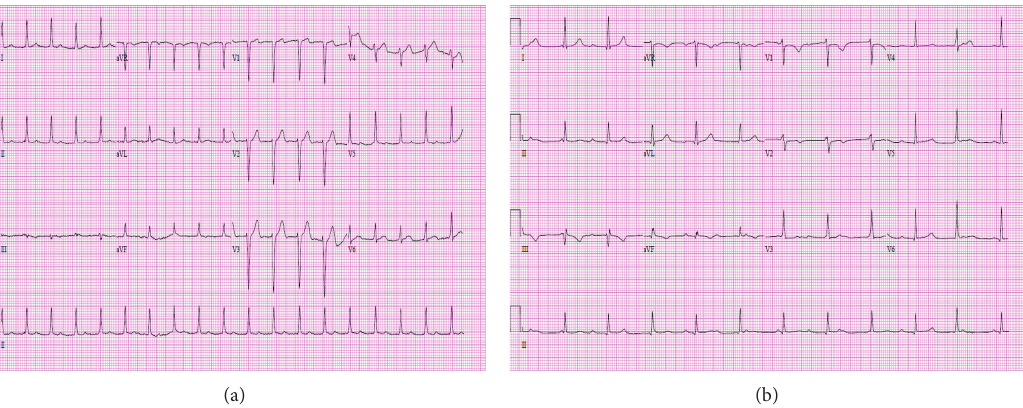
Figure 2: Electrocardiogram. Day 1 ECG on left and day 2 on right. Day 1 ECG reveals probable sinus tachycardia with first-degree heart block at 111bpm. Day 2 ECG shows complete heart block with a ventricular rate of 67